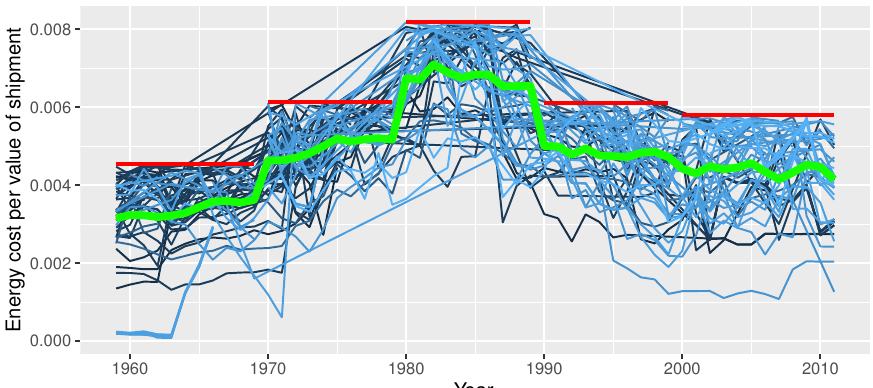
Figure 1. Energy intensity of industries. Shown are industries whose energy intensity are lower than the 10th percentile in a respective decade. Notes: Horizontal red lines show the 10th percentile of energy intensity in a respective decade. The bold green solid line shows the mean of energy intensity for industries whose energy intensity are lower than the 10th percentile in a respective decade.